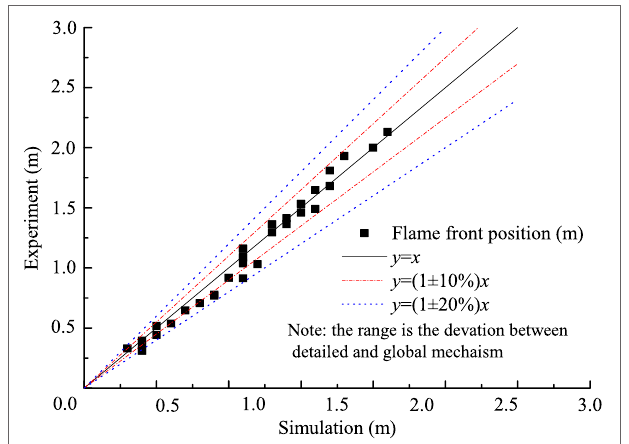
FIGURE 5 | Comparison of flame front positions between updated kinetics and experiments.